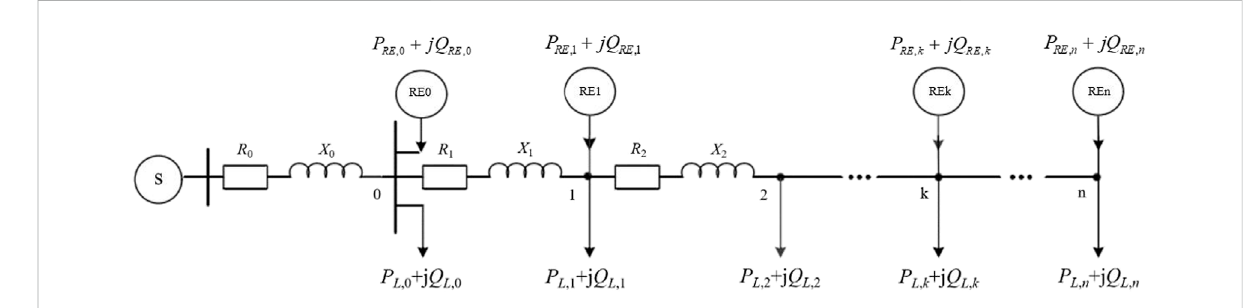
FIGURE 1 Topology of distribution network with renewable